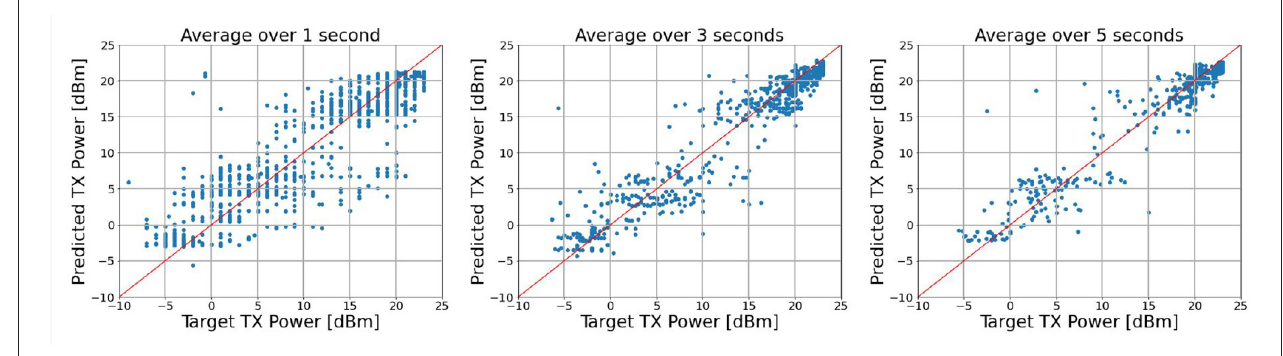
FIGURE 5 | Scattering plots between predictions and true